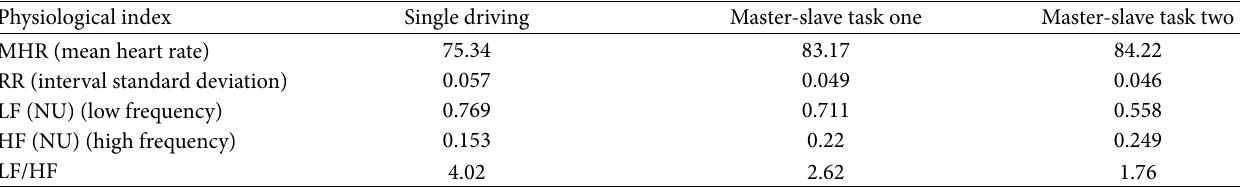
Figure 6: The test path for this research. Table 2: Average of ECG index (day).